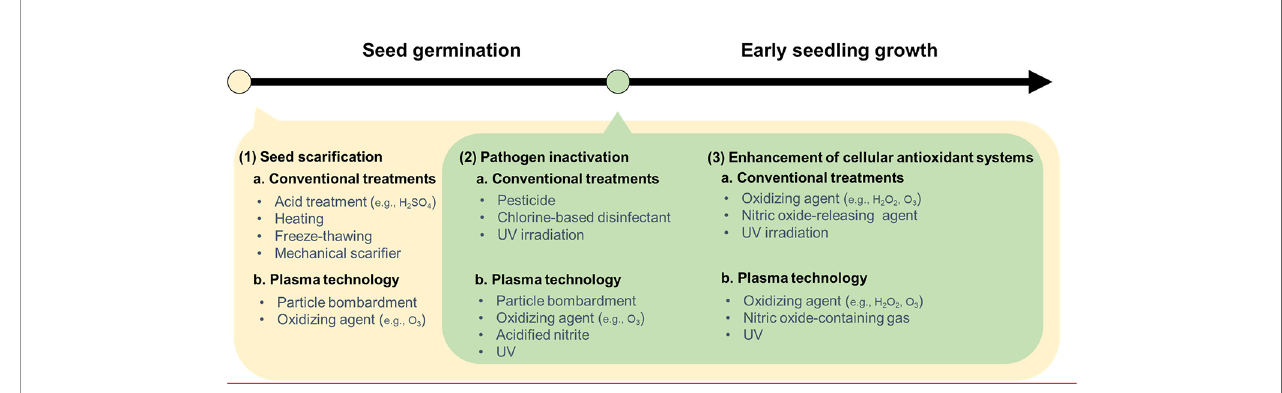
FIGURE 1 | A comparison of plasma technology and conventional treatments with three factors affecting seed invigoration and seedling establishment: 1) seed scari fi cation, 2) pathogen inactivation, and 3) enhanced cellular antioxidant systems. Seed scari fi cation conventionally is done by acid treatment, heating, freeze- thawing, and mechanical scari fi er. Plasma technology, as a particle bombardment or an oxidizing agent or both, can also be used for seed scari fi cation at presowing. Additionally, plasma treatment, like other possible agents, can be applied at the early growth stage. Traditionally, synthetic chemicals have been commonly used for pathogen inactivation and antioxidant system